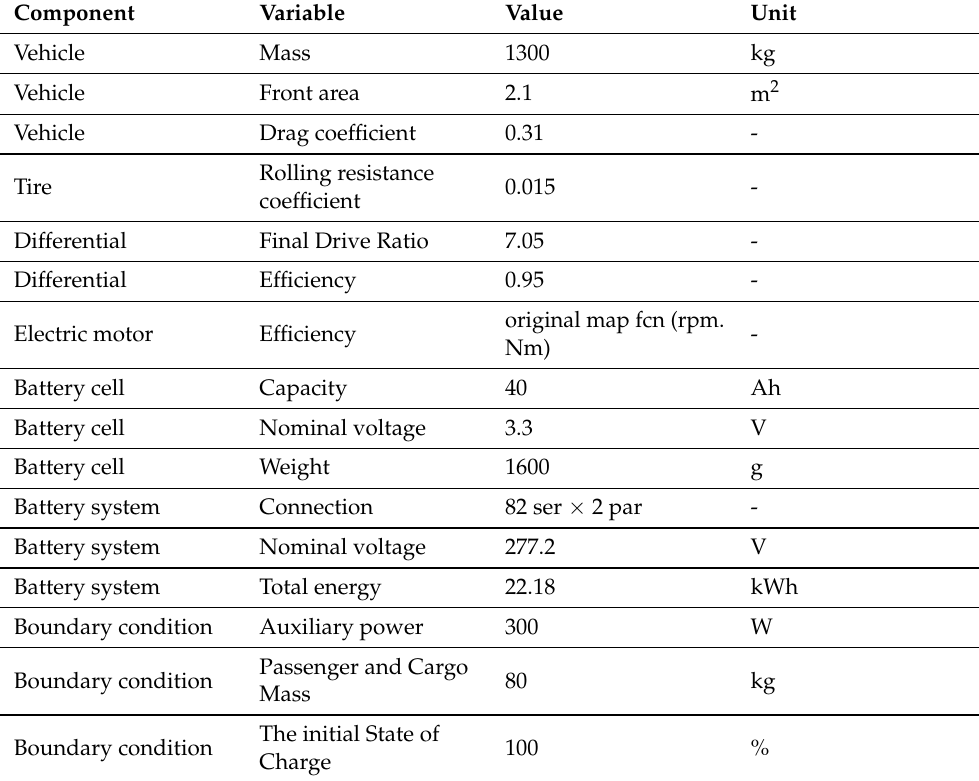
Table 1. Modified vehicle parameters and parameters that influence the performance simulation the most.